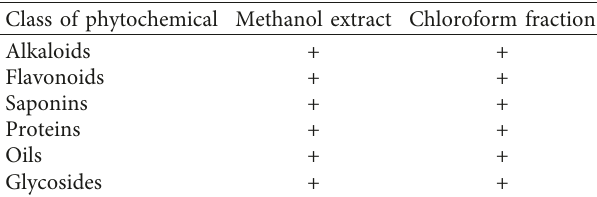
Table 5: Qualitative phytochemical analysis of Nepeta distans.